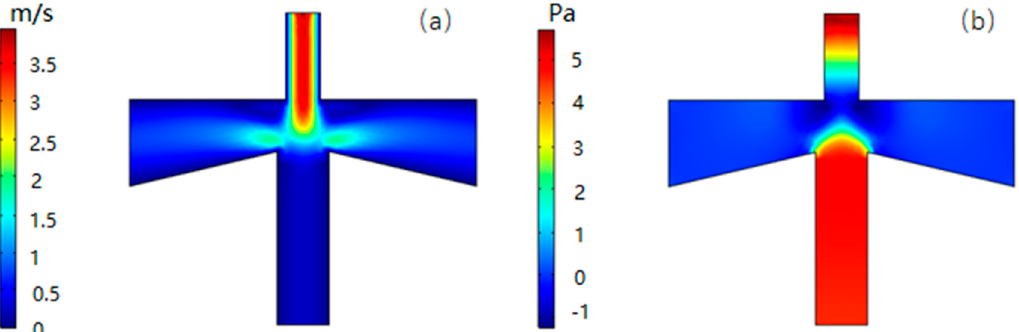
Figure 8. Velocity ( a ) and pressure ( b ) distribution in VI.